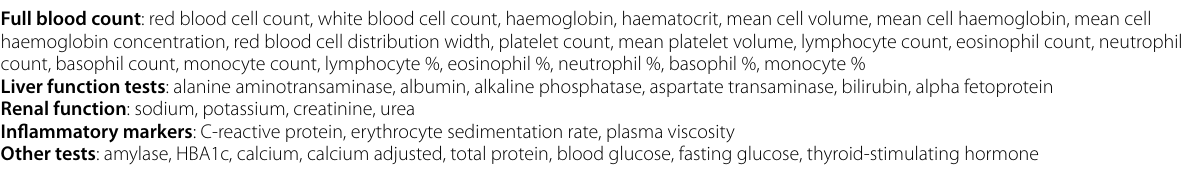
Table 1 Blood tests under investigation in BLOTTED Full blood count : red blood cell count, white blood cell count, haemoglobin, haematocrit, mean cell volume, mean cell haemoglobin, mean cell haemoglobin concentration, red blood cell distribution width, platelet count, mean platelet volume, lymphocyte count, eosinophil count, neutrophil count, basophil count, monocyte count, lymphocyte %, eosinophil %, neutrophil %, basophil %, monocyte % Liver function tests : alanine aminotransaminase, albumin, alkaline phosphatase, aspartate transaminase, bilirubin, alpha fetoprotein Renal function : sodium, potassium, creatinine, urea Inflammatory markers : C-reactive protein, erythrocyte sedimentation rate, plasma viscosity Other tests : amylase, HBA1c, calcium, calcium adjusted, total protein, blood glucose, fasting glucose, thyroid-stimulating